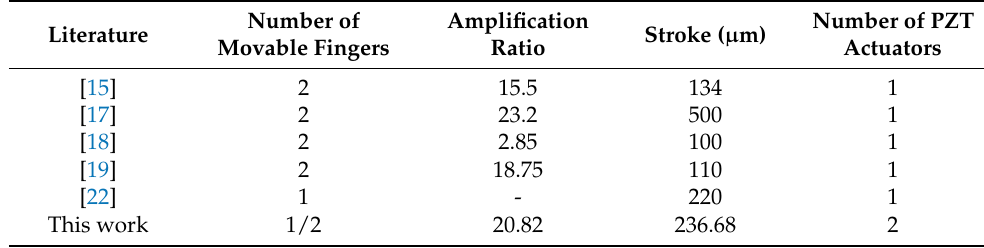
Table 2. The comparison with the existing